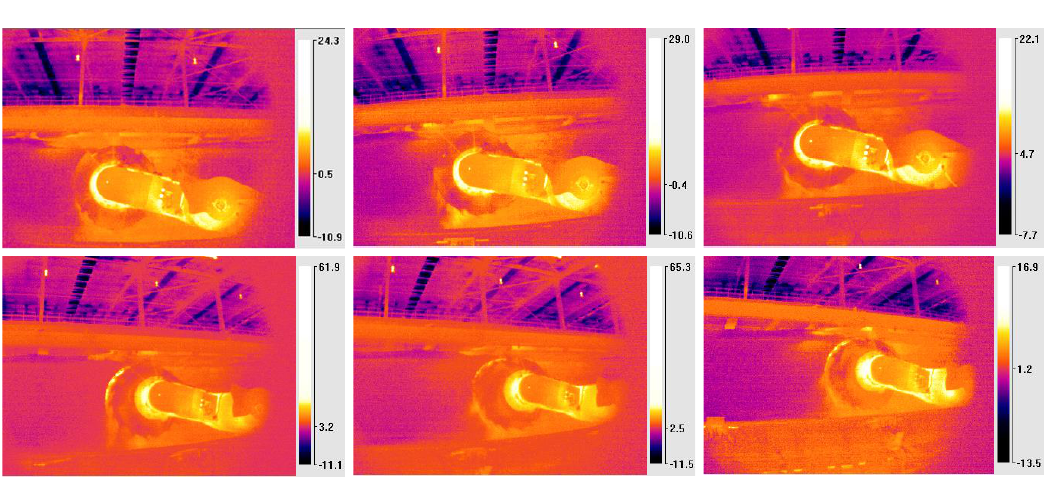
Figure 17. Temperature changes in the infrared thermal image of a continuously cutting shearer.